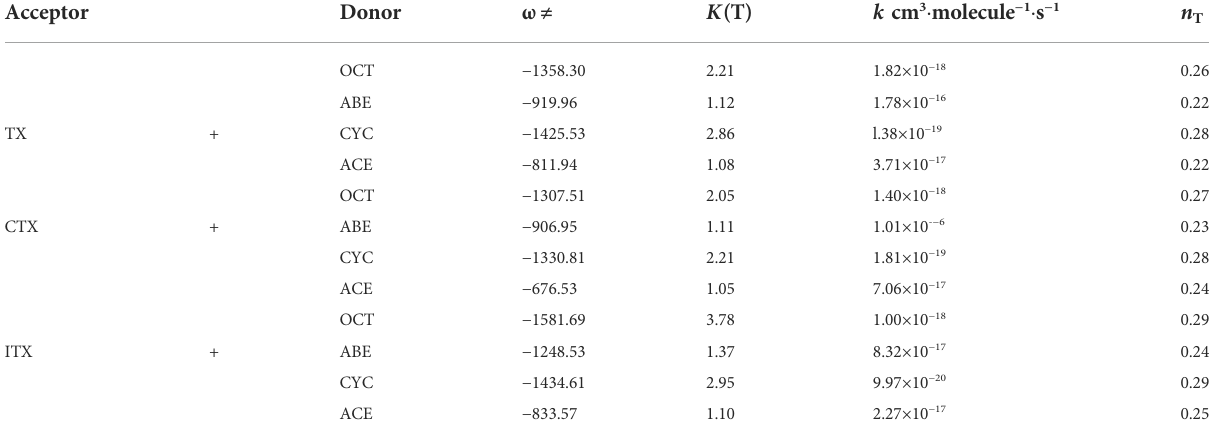
TABLE 3 Imaginary frequencies, tunneling factors, rate constants, and bond orders of the twelve reactions.